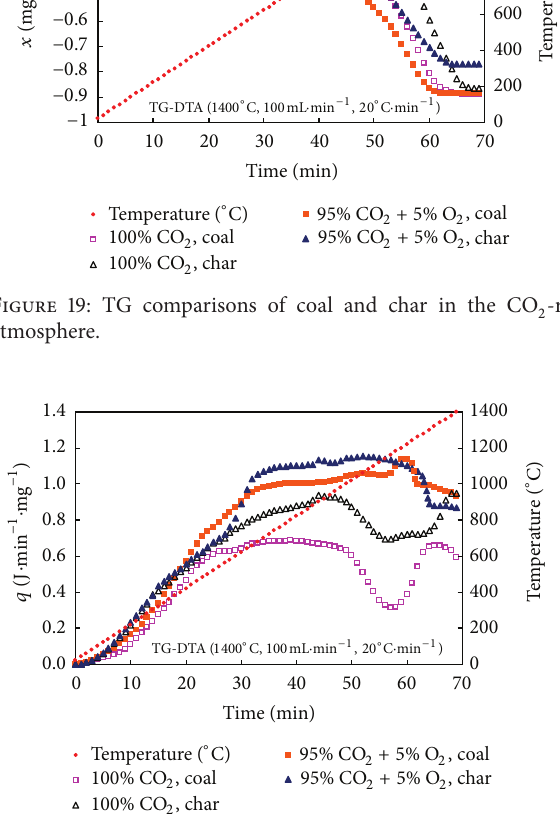
Figure 20: DTA comparisons of coal and char in the CO 2 -rich atmosphere.